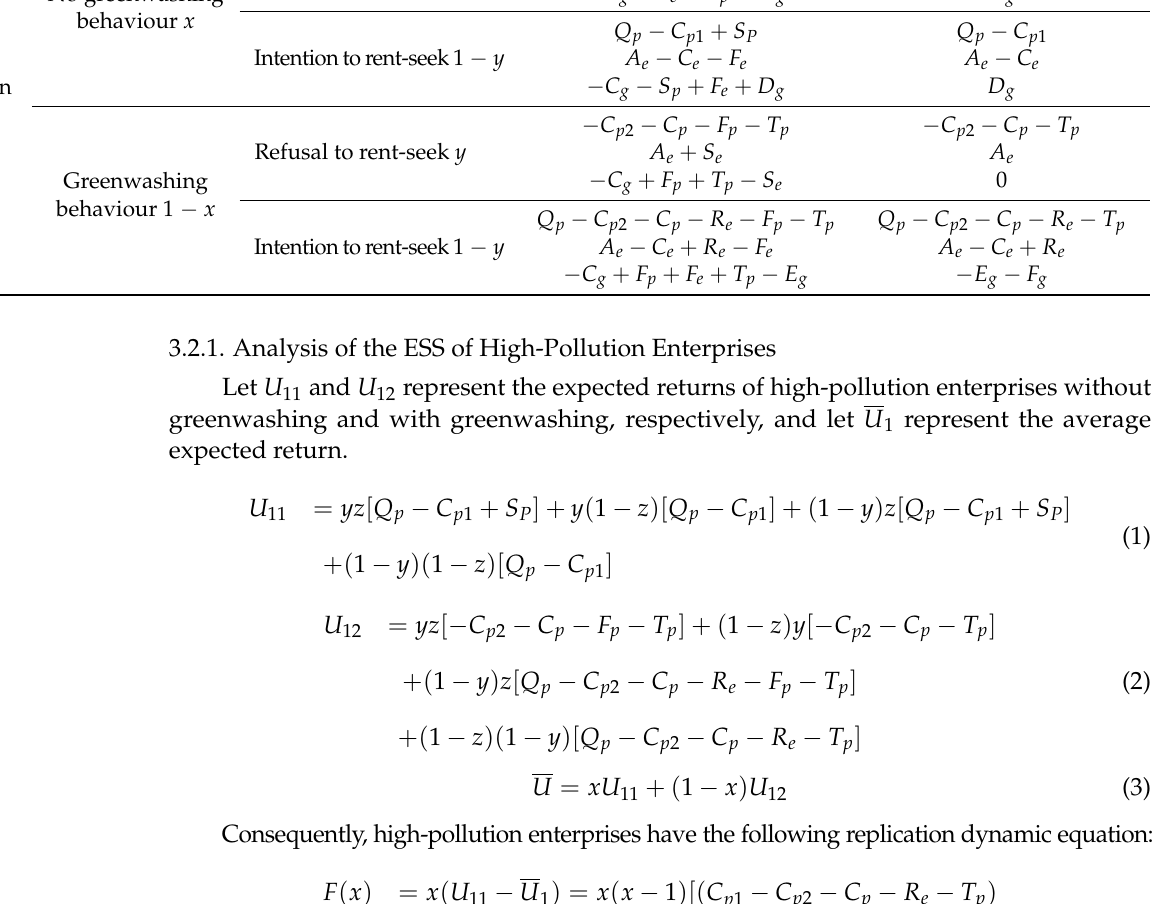
High-pollution enterprises